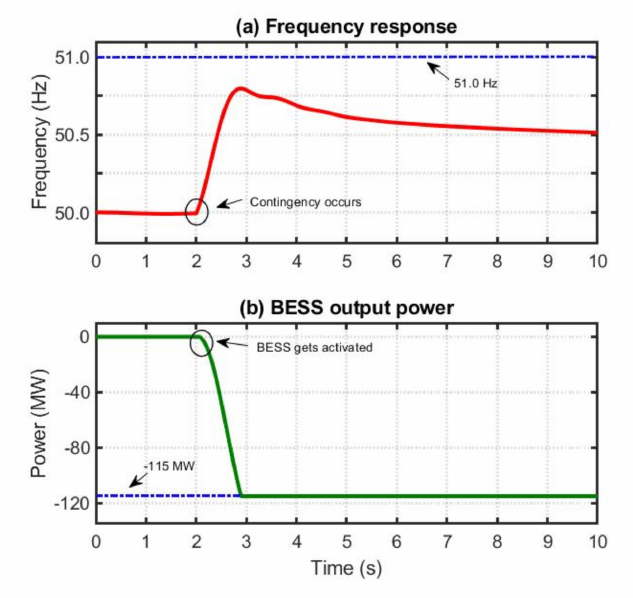
Figure 11. Frequency responses and BESS output due to 450-MW interconnection trip in five-machine